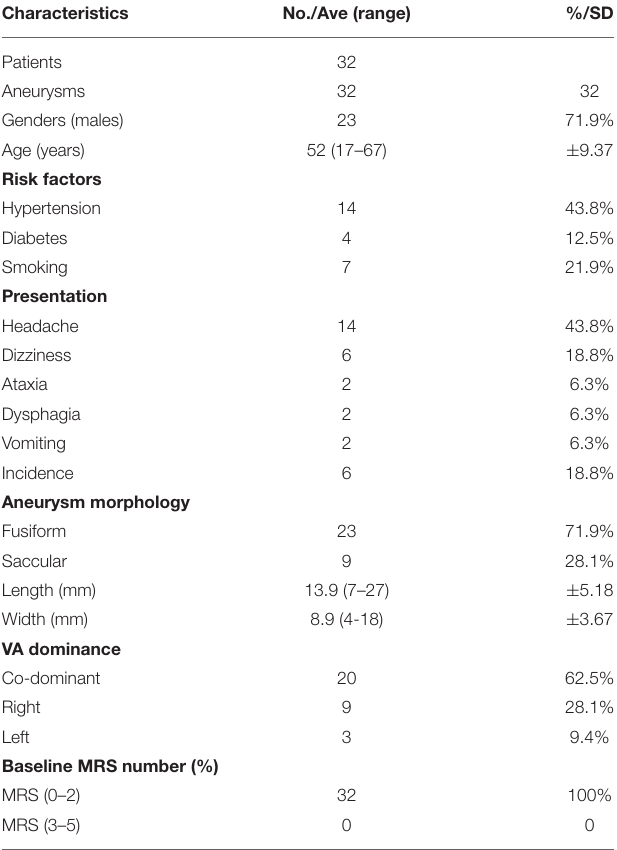
TABLE 1 | Basic information and aneurysm